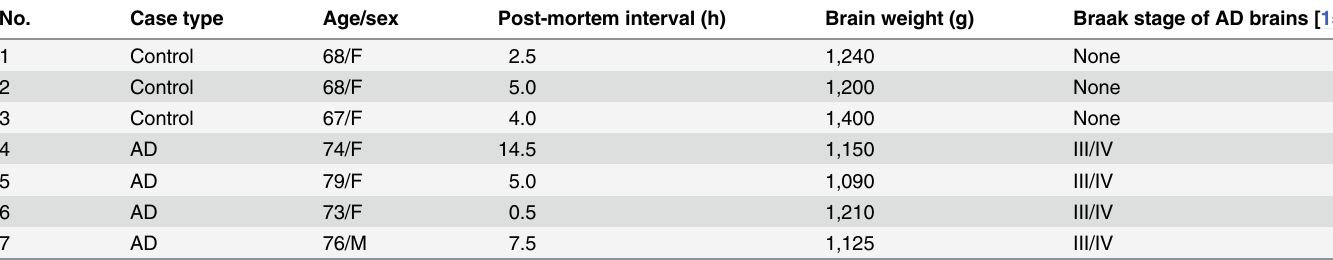
Table 2. Demographic details of post-mortem brain specimens from controls and Alzheimer ’ s disease patients.